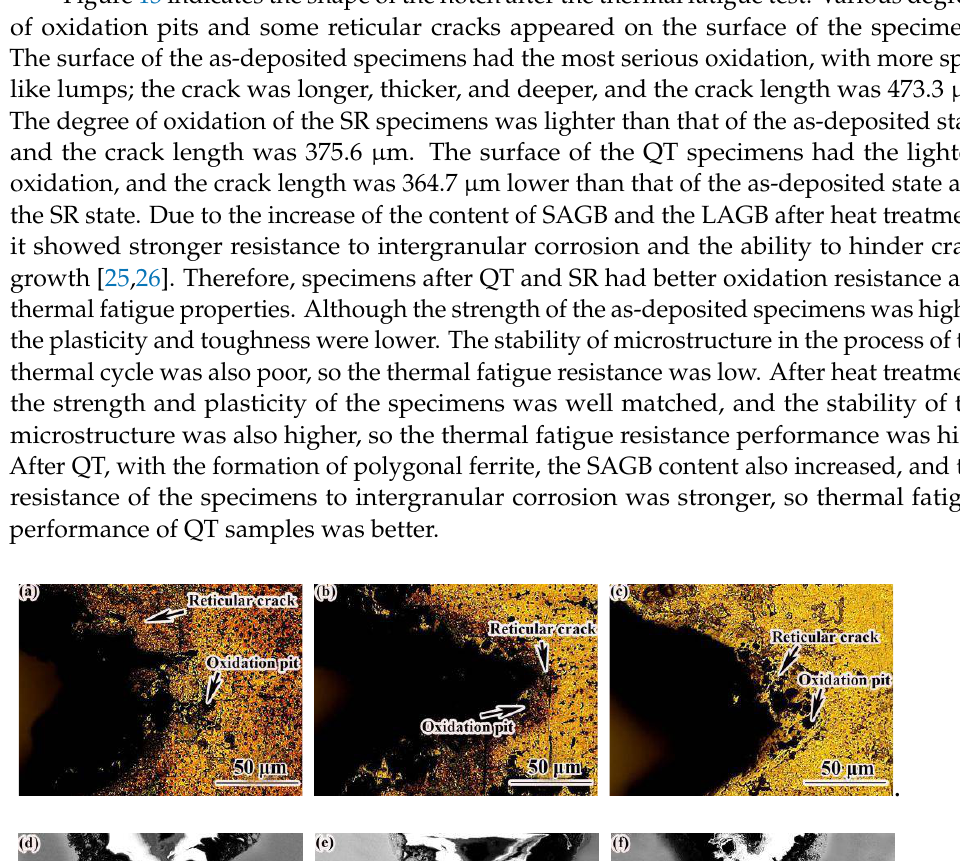
Figure 12. High temperature friction and wear morphologies of samples in different states: ( a ) as- deposited; ( b ) QT; ( c ) SR.